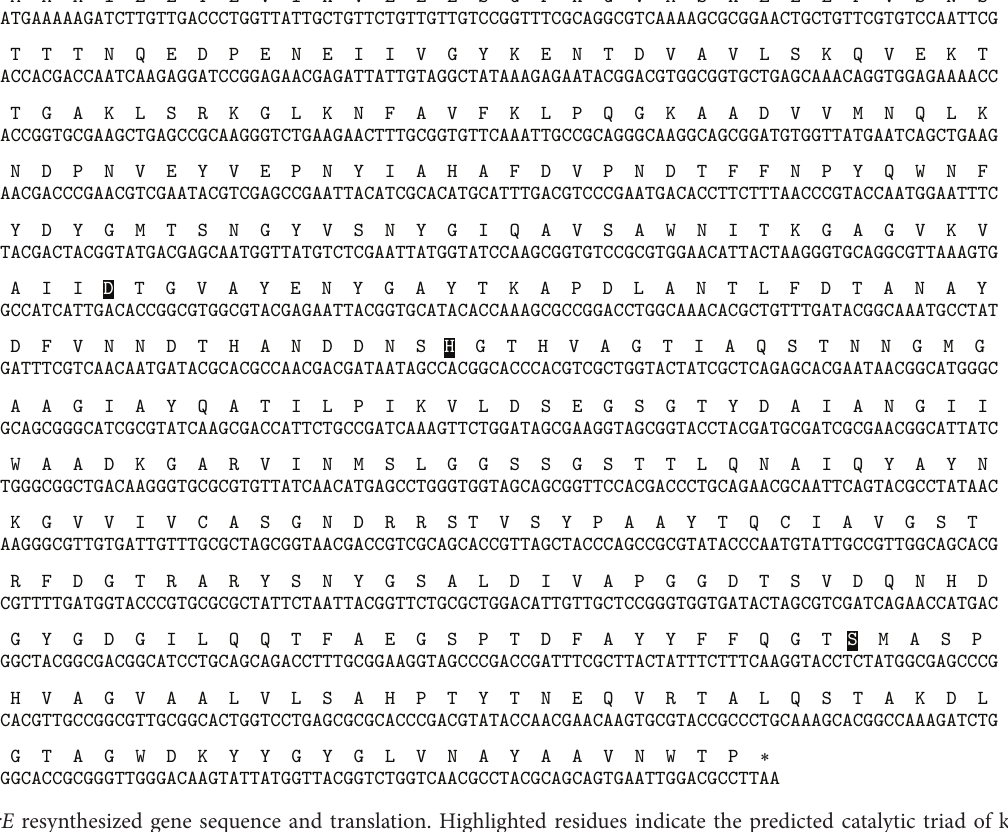
Figure 1: aprE resynthesized gene sequence and translation. Highlighted residues indicate the predicted catalytic triad of known serine proteases.